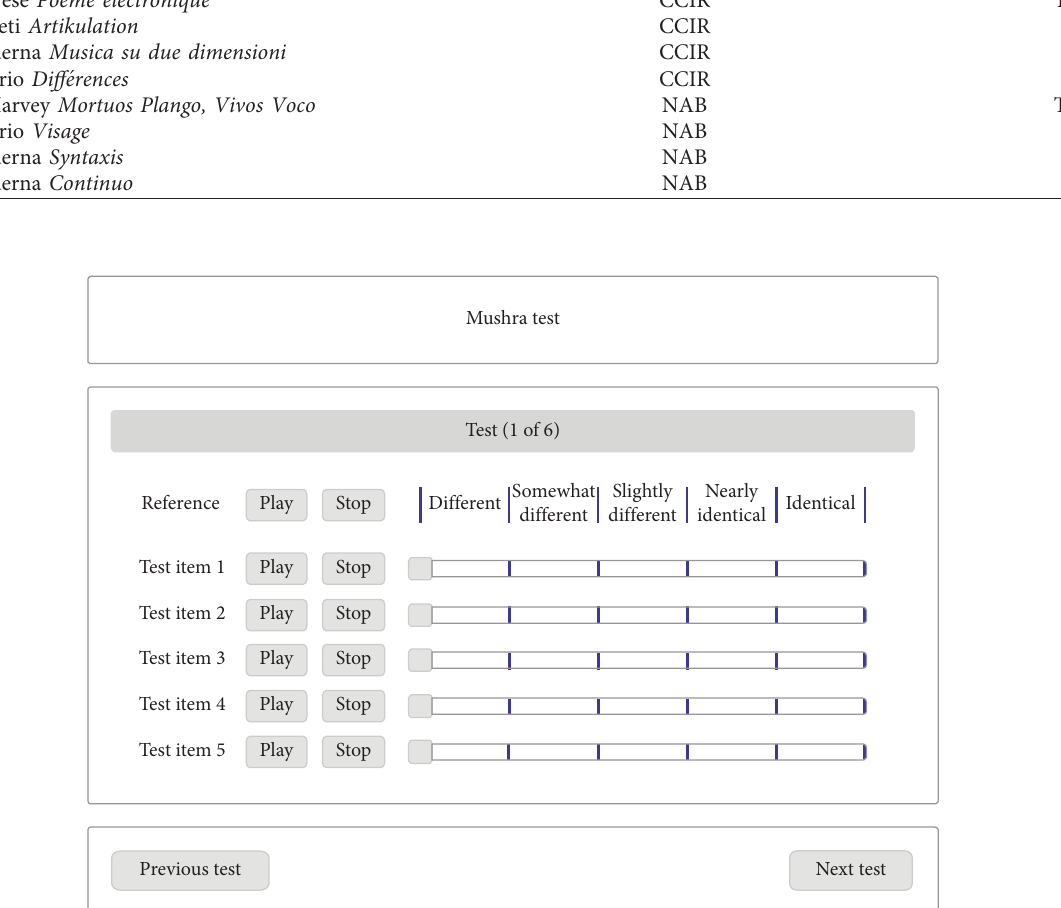
Figure 3: Screenshot of the MUSHRA-inspired test interface, showing one of the 6 nontest examples.